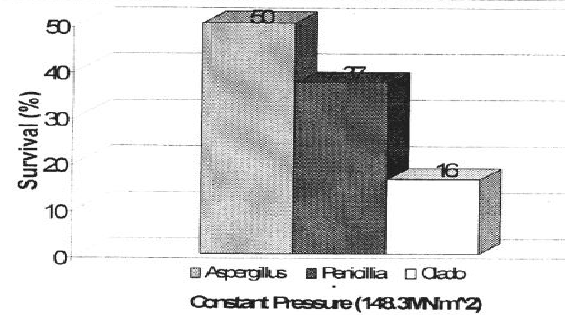
Figure 2 : survival of 10 4 ASP flavus penicillia and cladosporia spores at constant pressure in multivitamin